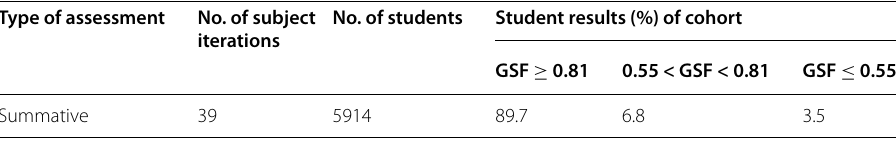
Table 6 The distribution of student GSF results during 2020 for summative SITPAT tasks Type of